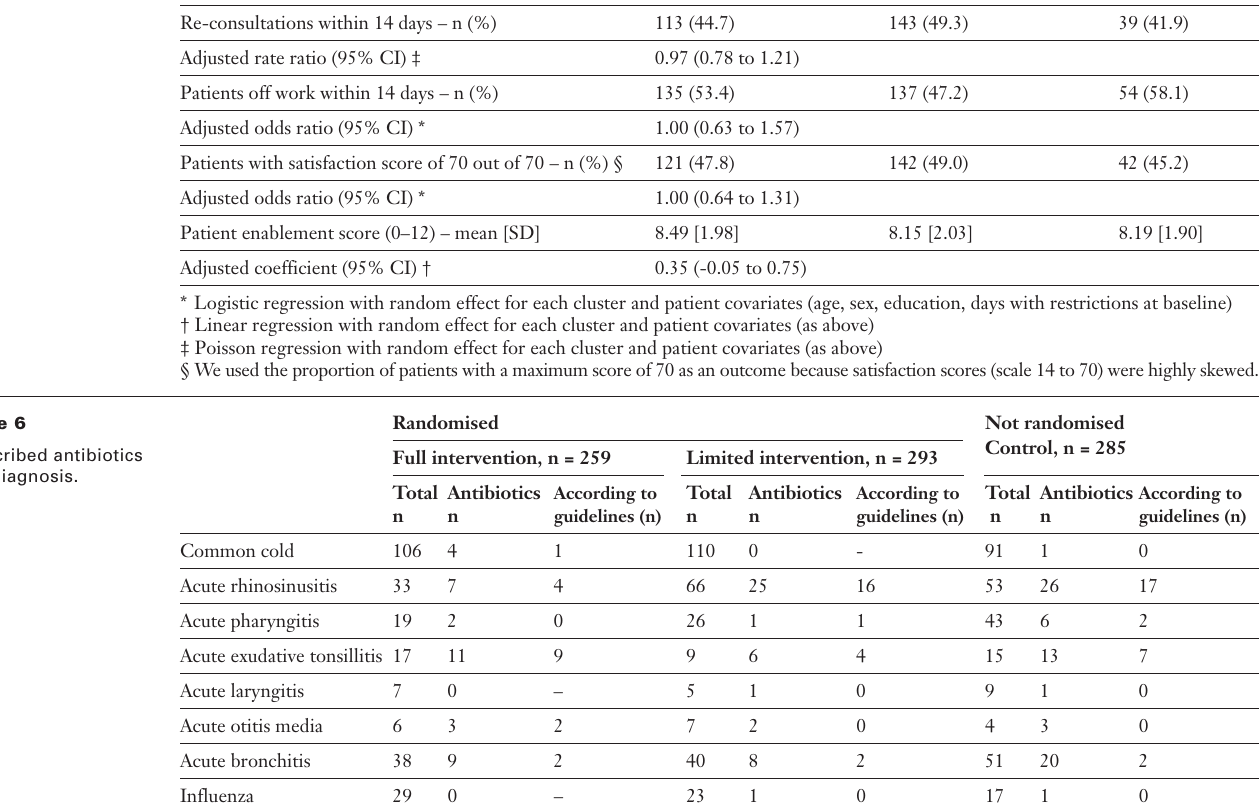
Table 4 Study patients.